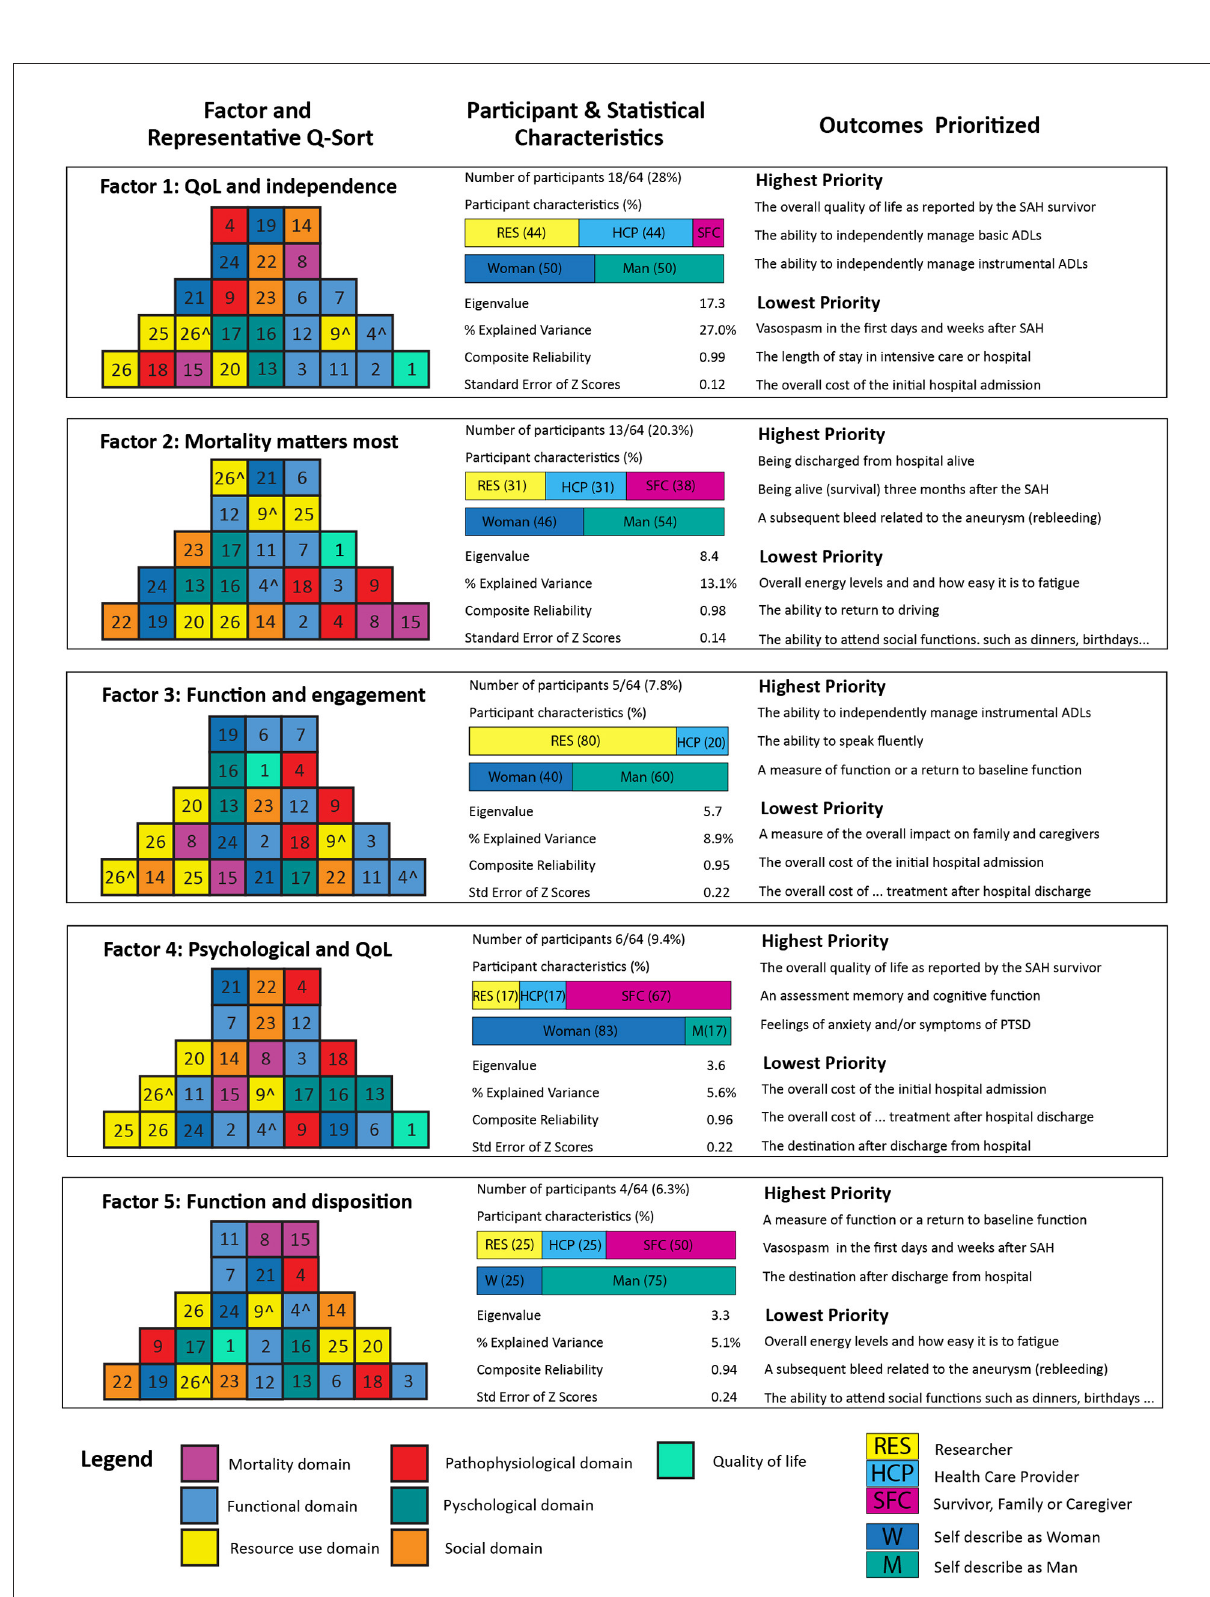
FIGURE3 The representative q-sorts (colored pyramids) for each of the 5 identified factors are shown. The highest ranked outcome measure is in the right corner, descending in importance as you move to the left of the q-sort. In each pyramid column the higher ranked outcome measure is at